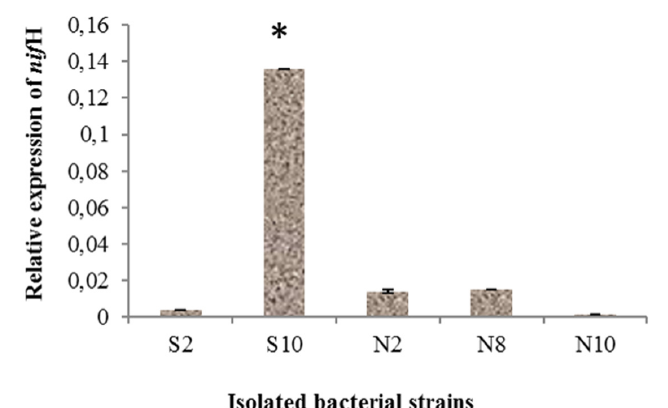
Figure 2. Semi-quantitative RT-PCR confirmation of nif H gene in the isolated bacterial strains. Each data point represents nif H transcripts levels. One-way ANOVA determined the significance of difference. Each data point represents mean and the vertical line on it indicates the standard